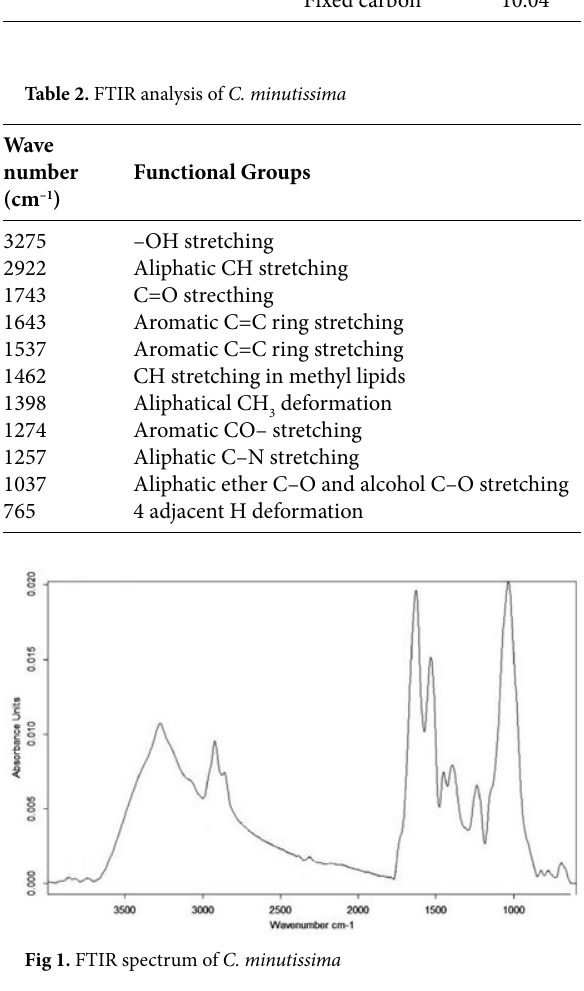
Fig 1. FTIR spectrum of C.